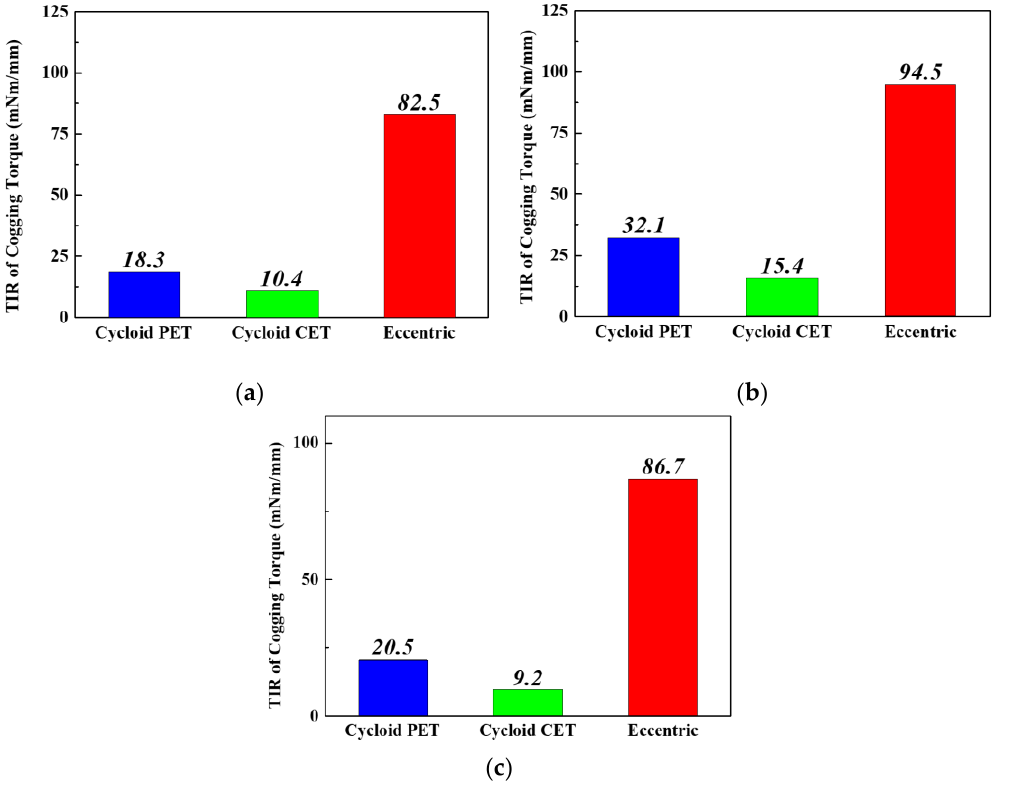
Figure 11. TIR of cogging torque (@ Δ δq = 3.25): ( a ) fabrication tolerance for position of permanent magnet; (b ) fabrication tolerance for residual magnetic flux density of permanent magnet; ( c ) fabrication tolerance for width of open slot.